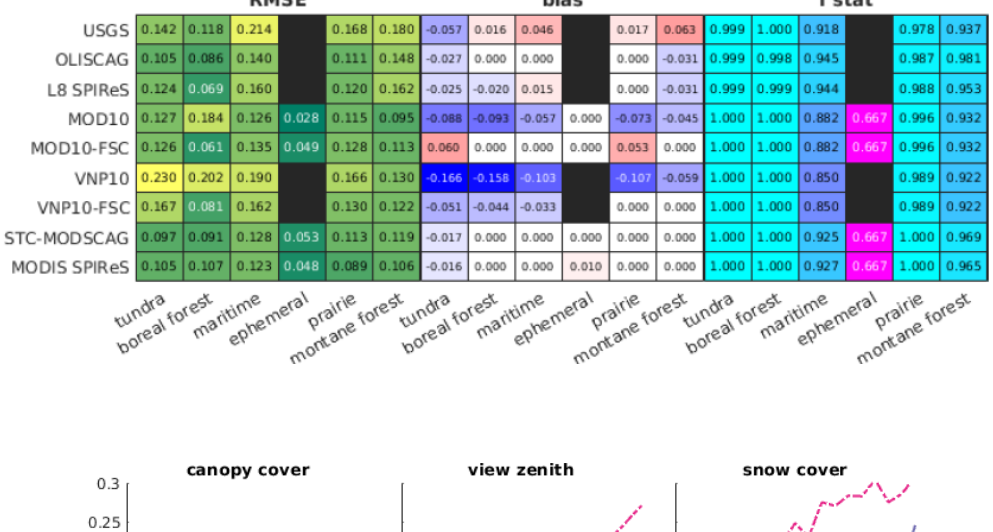
Table 4. Heat maps of the algorithm performance results (colored by RMSE, bias, and F statistic) corresponding to seasonal snow cover